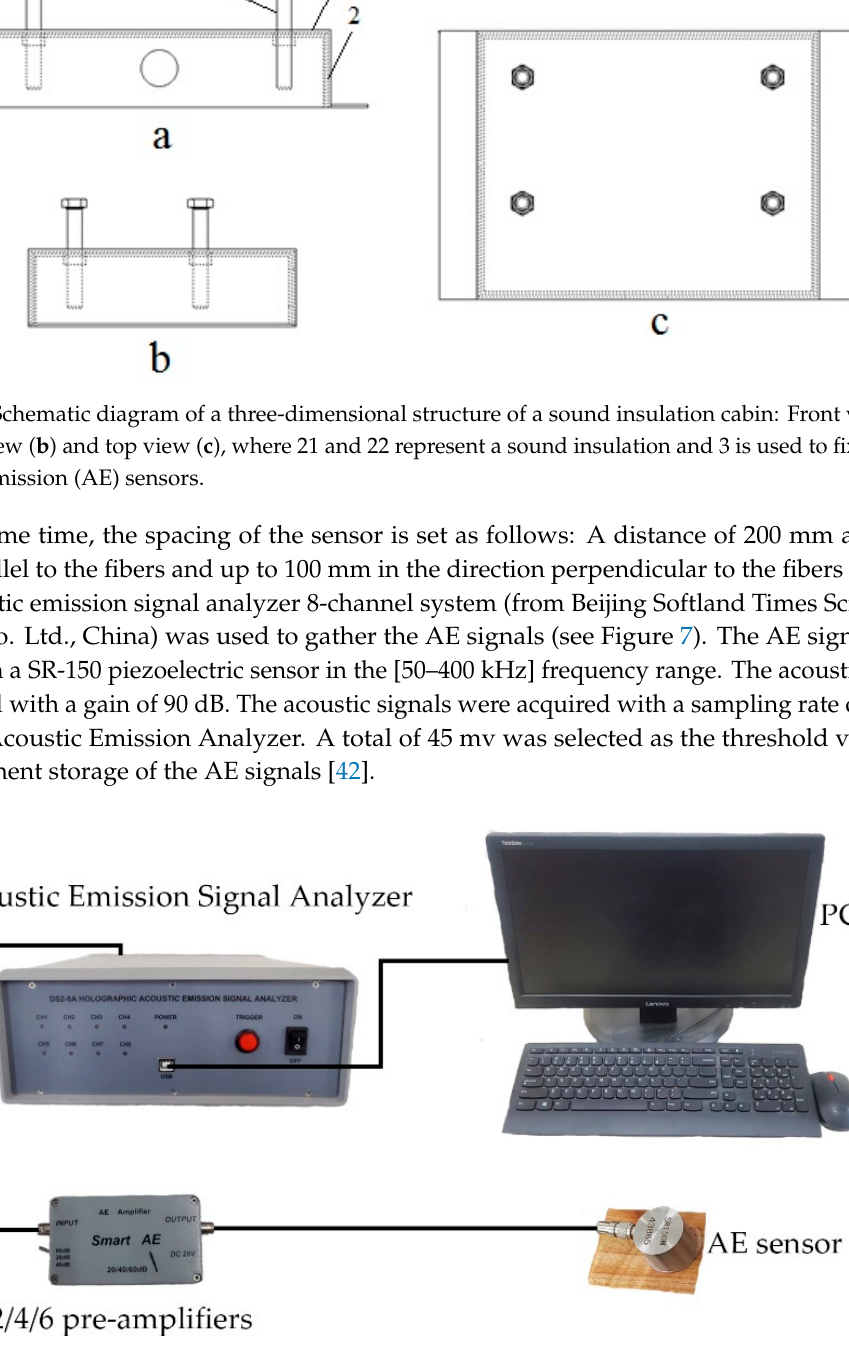
Figure 7. A diagram to show the instrument connection for acoustic emission.